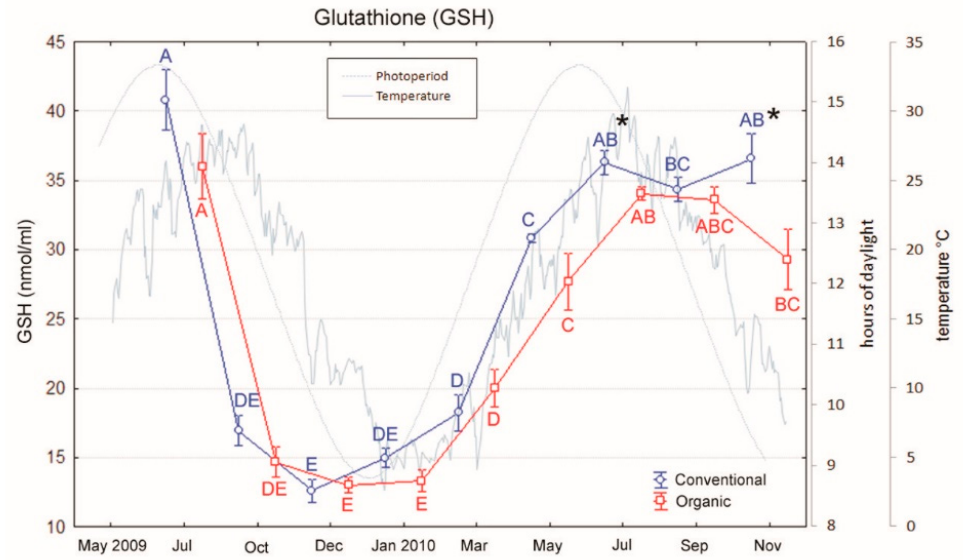
Figure 7. Variations in glutathione of sea bass over an 18-month period (mean ± SE) reared under conventional and organic aquaculture. Different letters indicate significant differences in samplings within the same feeding system (organic or conventional; p < 0.05). Asterisks indicate significant differences between systems within the same sampling ( p < 0.05).